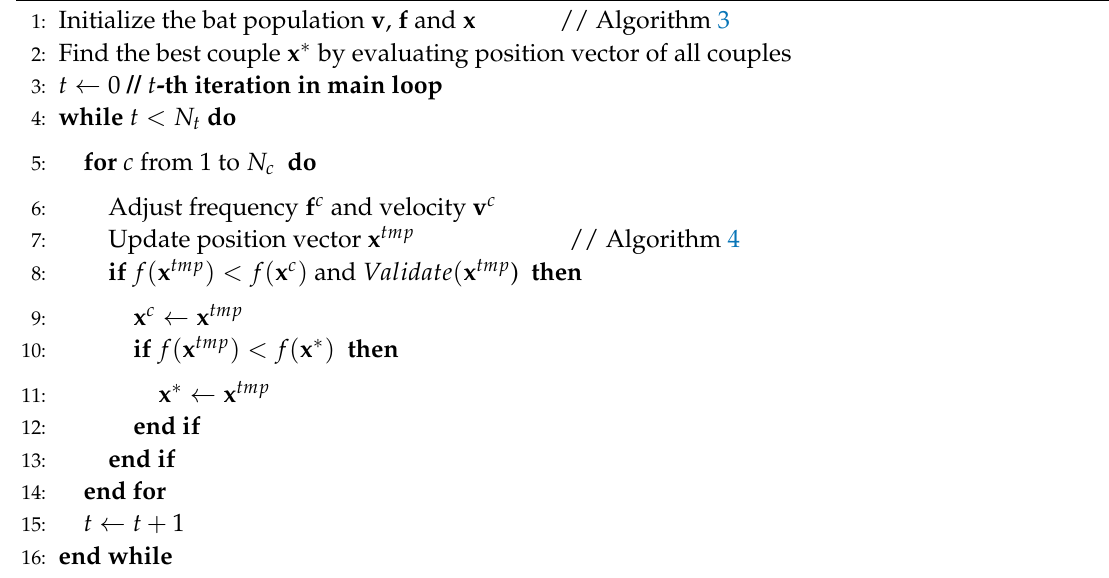
Figure 3. Position vector for a bat couple. Algorithm 2 Proposed bat algorithm for connected